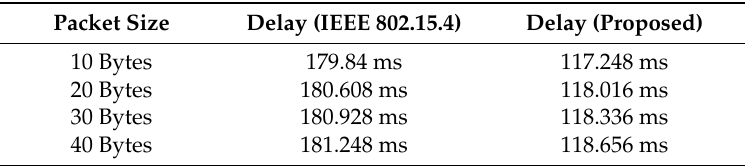
Table 4. Minimum achievable delay of co-related medical traffic in case of emergency events for the proposed and conventional schemes according to the packet size (worst case).